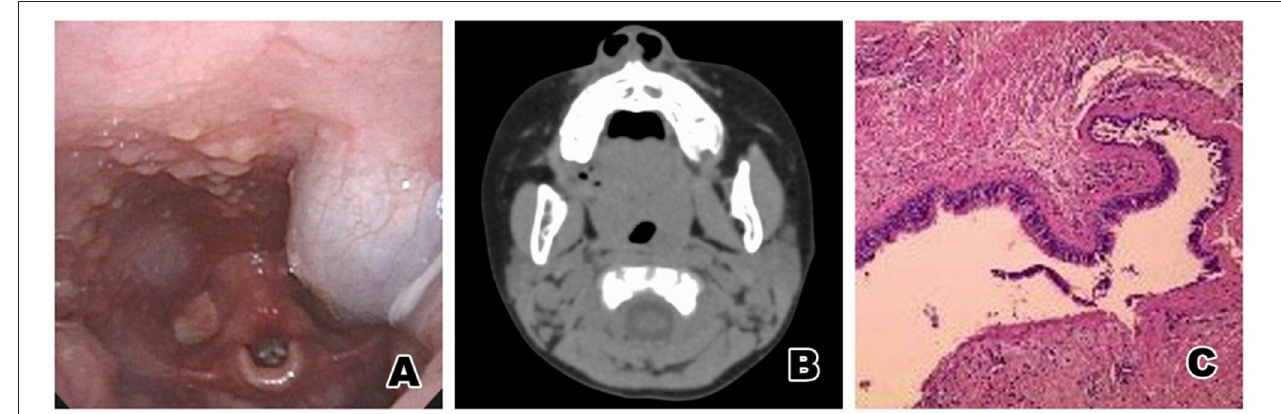
FIGURE 3 | (A) Electronic nasopharyngoscopy before surgery: A cystic mass with a smooth surface and a size of ∼ 1.2 × 1.3cm can be seen in the lateral wall of the posterior pharynx of the left palatopharyngeal arch. (B) Pharynx CT: a left parapharyngeal quasi-round space-occupying lesion. The left piriform recess becomes shallow, a liquid low-density shadow can be seen in it, and the gas and liquid are balanced. (C) Pathological results: The cyst cavity was lined with squamous epithelium and pseudostratified ciliated columnar epithelium, and salivary glands, smooth muscle, cartilage tissue and lymphocyte infiltration were seen under the epithelium. The pathological result was a bronchogenic cyst of the